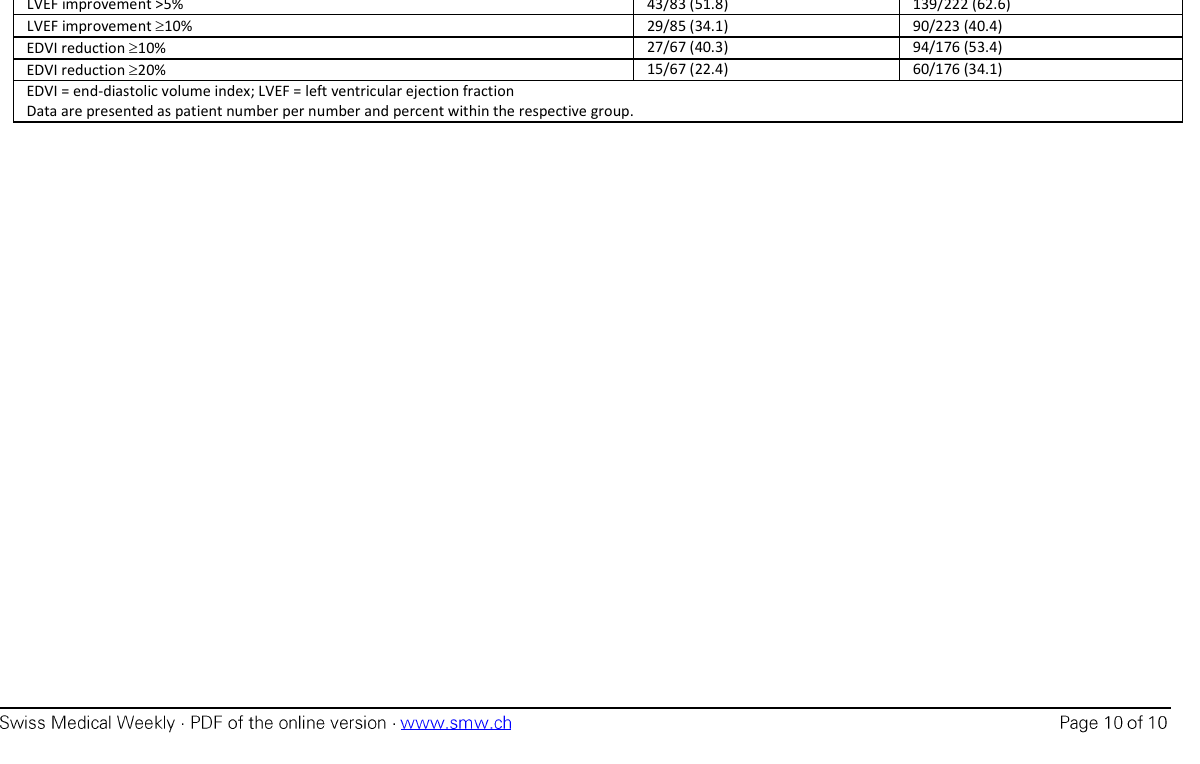
Table S6: Echocardiographic therapy response stratified by bundle branch block morphology. Rhythm at